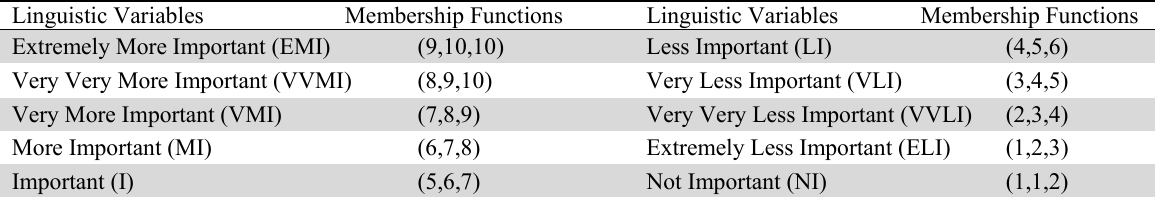
Linguistic variables for ratings of